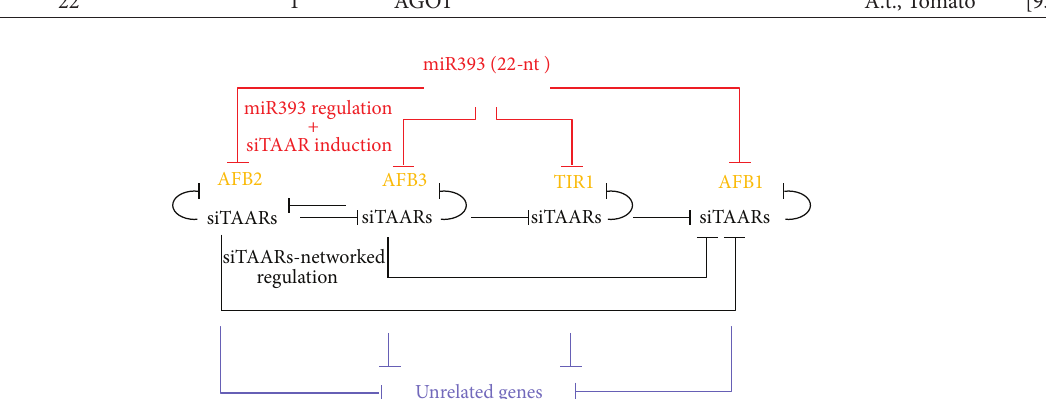
F 8: Complex network regulation of siTAARs initiated by miR393. Upon cleavage of TIR1/AFB2 auxin receptor (TAAR) transcripts by miR393 (red lines), secondary siRNAs (siTAARs) are generated. siTAARs regulate the expression of their source transcript in cis (dark lines) of other TAAR transcripts in trans (transverse dark lines) and of unrelated transcripts (blue lines) in trans. e network has important role in auxin homeostasis and plant